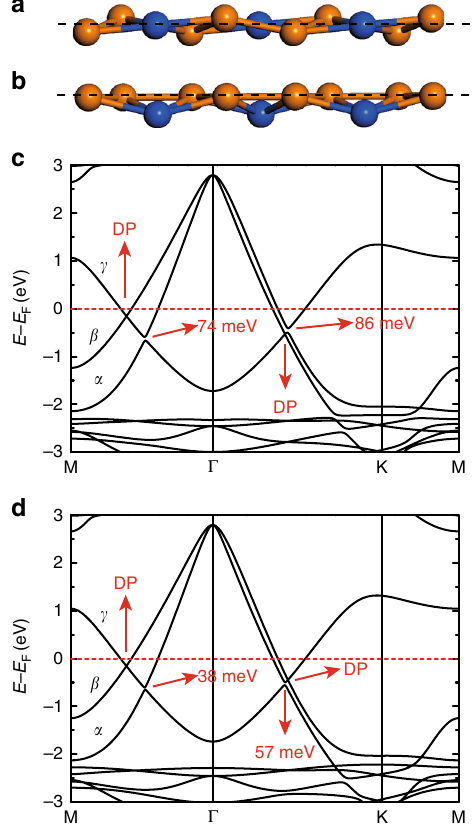
Fig. 2 Band structures of Cu 2 Si without SOC after breaking the mirror re fl ection symmetry. a , b Two con fi gurations that break the mirror re fl ection symmetry in Cu 2 Si. a the neighbouring Cu atoms have a 0.1 Å buckling while the Si atoms remain in-plane; b the Si atoms are shifted 0.1 Å downwards. The shift of atoms is enlarged for clarity. The horizontal dashed lines indicate the original plane where all atoms were located before the shift. c , d Calculated band structures for the two con fi gurations in a , b . The nodal lines are gapped, except for one gapless Dirac point (DP) along the Γ -M and Γ -K directions. The sizes of the gaps are indicated in c ,